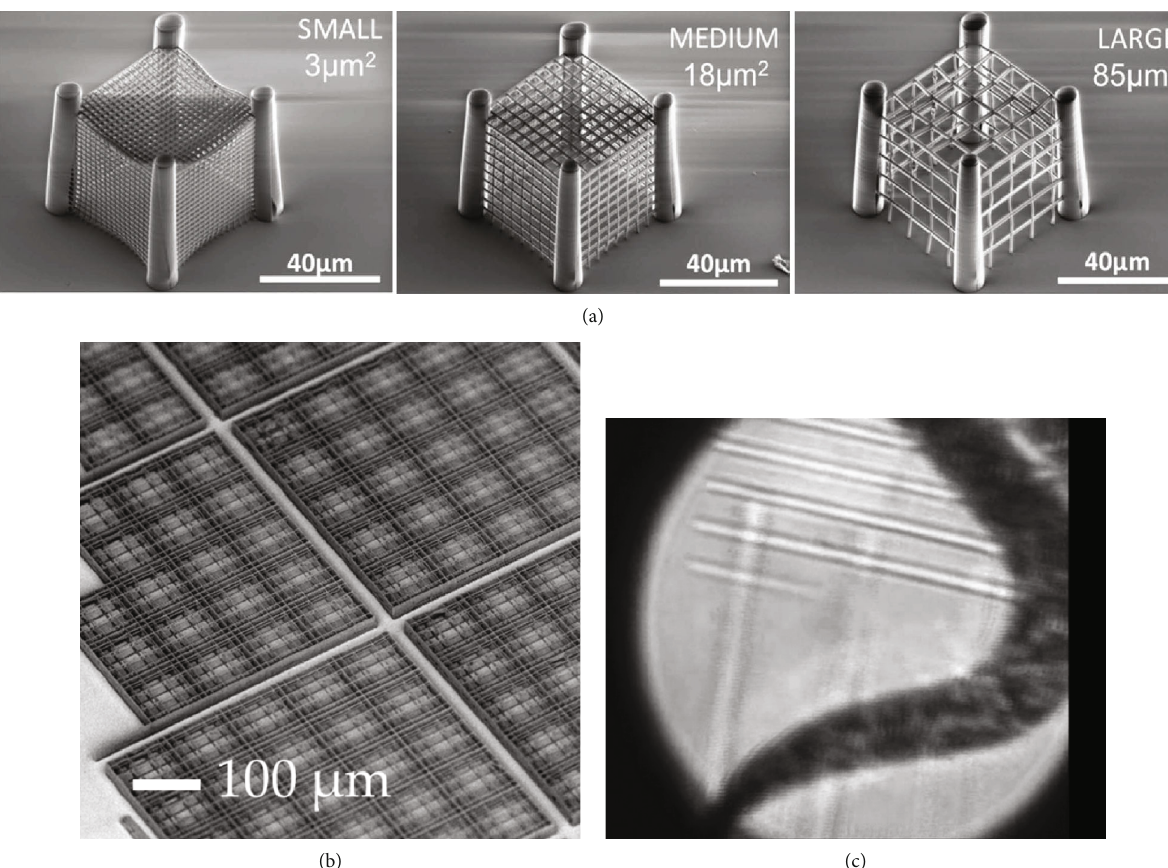
Figure 12: (a) SEM images of 3DLL-made structures with varied pore areas used to test cell interaction in sca ff olds which might be smaller than the cell itself [186]. (b) Supermatrix of nichoids as a cell culture containing 218 matrices at a distance of 30 μ m. Such structures show clear capabilities of 3DLL to be employed at mass production of biological sca ff olds [73]. (c) Real-time view via setup imaging system depicting the writing of a sca ff old in the presence of a living Caenorhabditis elegans showcasing that 3DLL combined with a biopolymer can be completely biofriendly and does not have adverse impact on living organisms